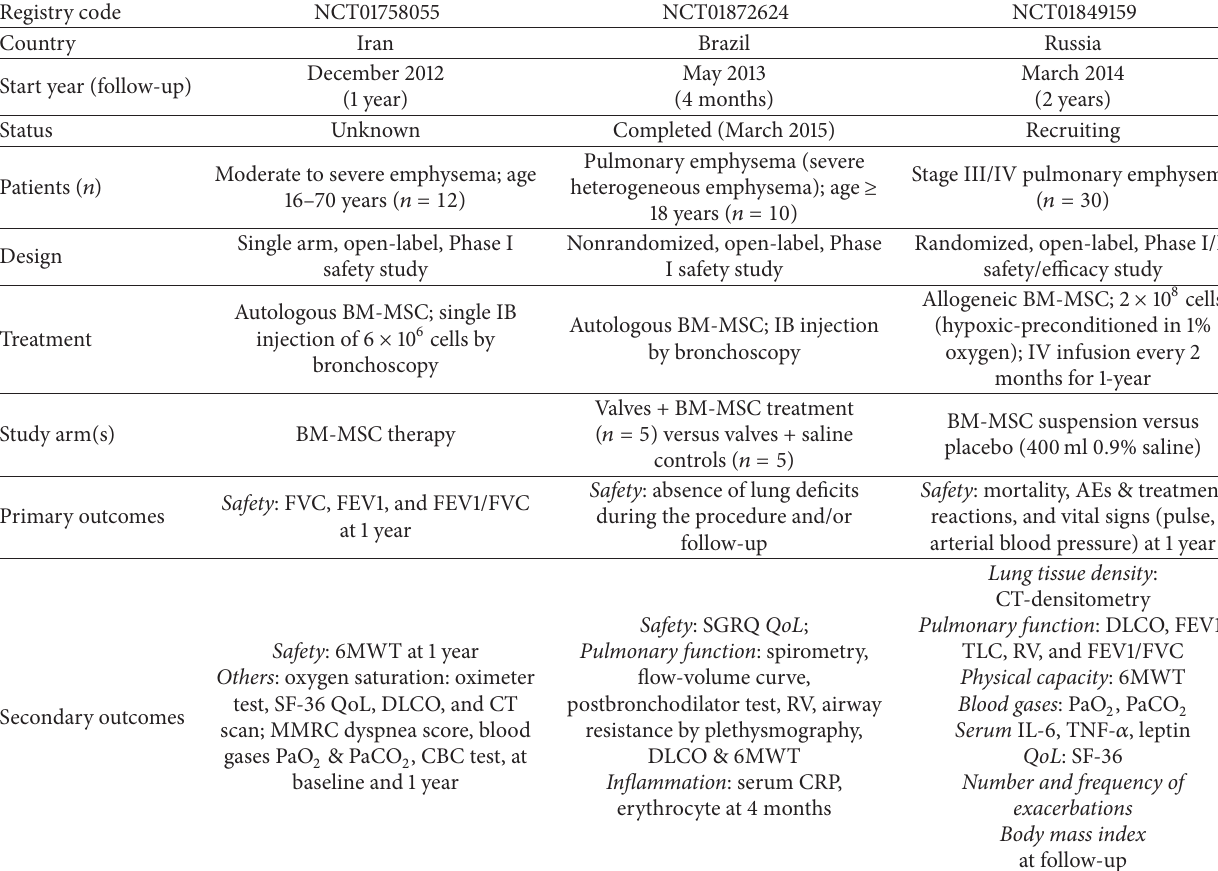
Table 4: Ongoing clinical trials with BM-MSC administration in COPD.